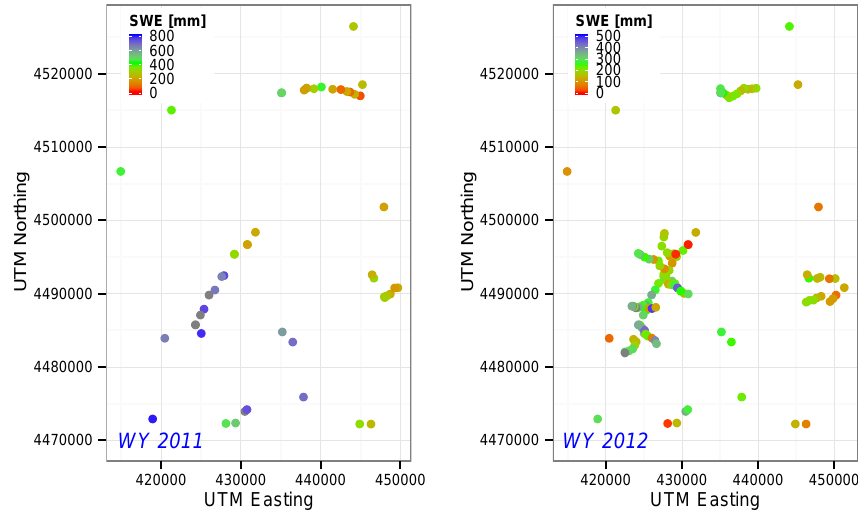
Fig. 7. SWE plotted against UTM Northing and UTM Easting for both WY 2011 and WY2012 snow surveys.